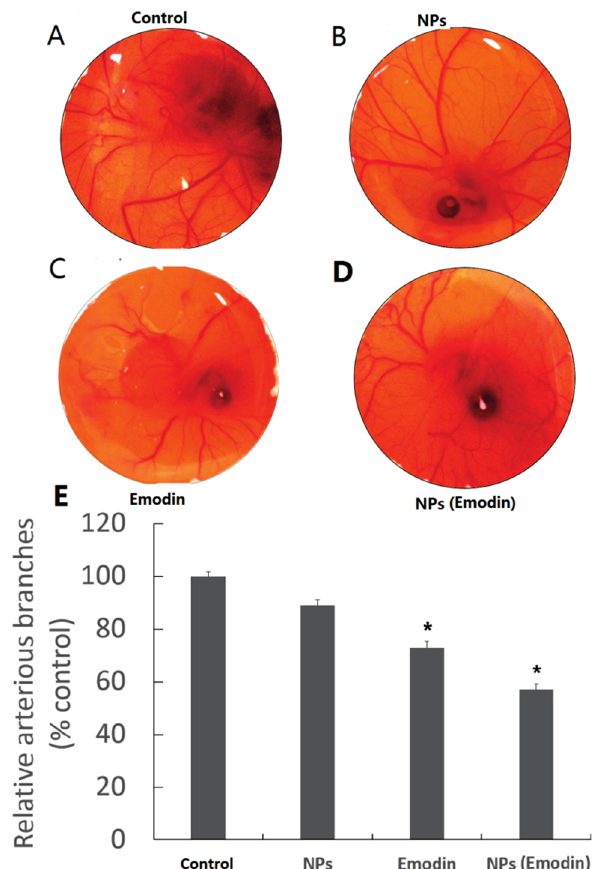
Figure 6. Blood vessel formation of fertilized chicken eggs incubated with different agents ( A – D ) and quantitative analysis ( E ). ( * p <